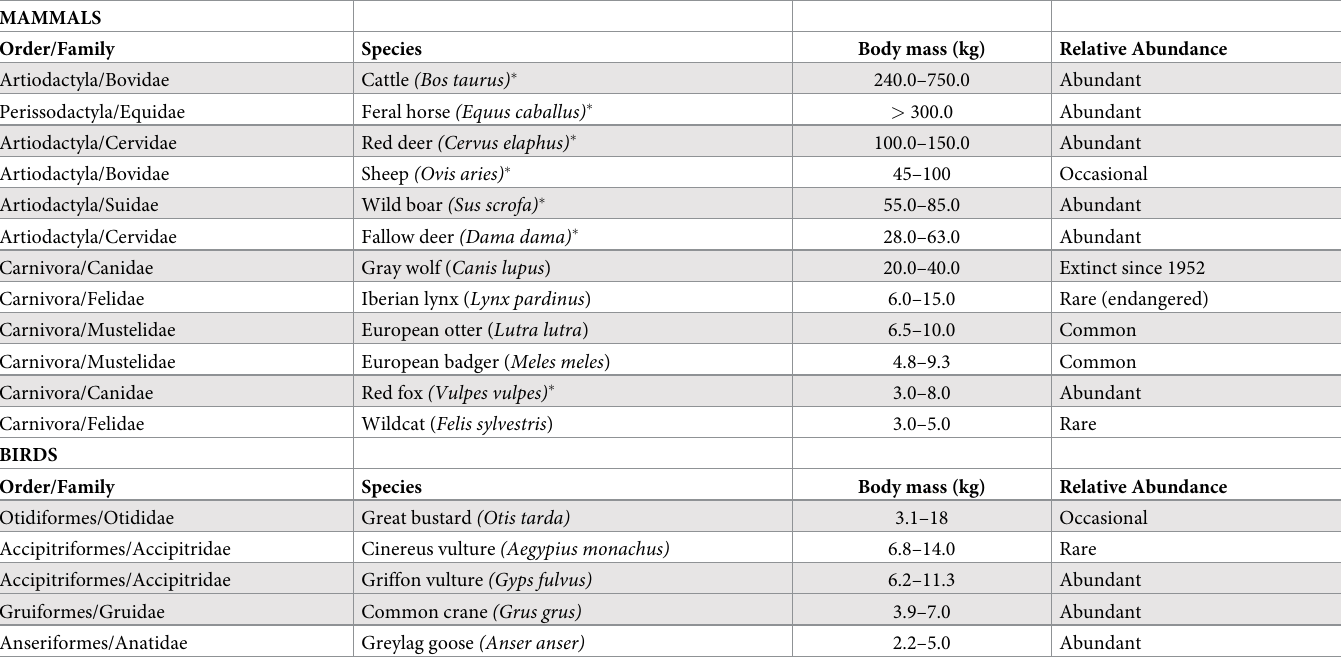
Table 2. List of mammals and birds larger than 5 kg body mass from Do ñ ana National